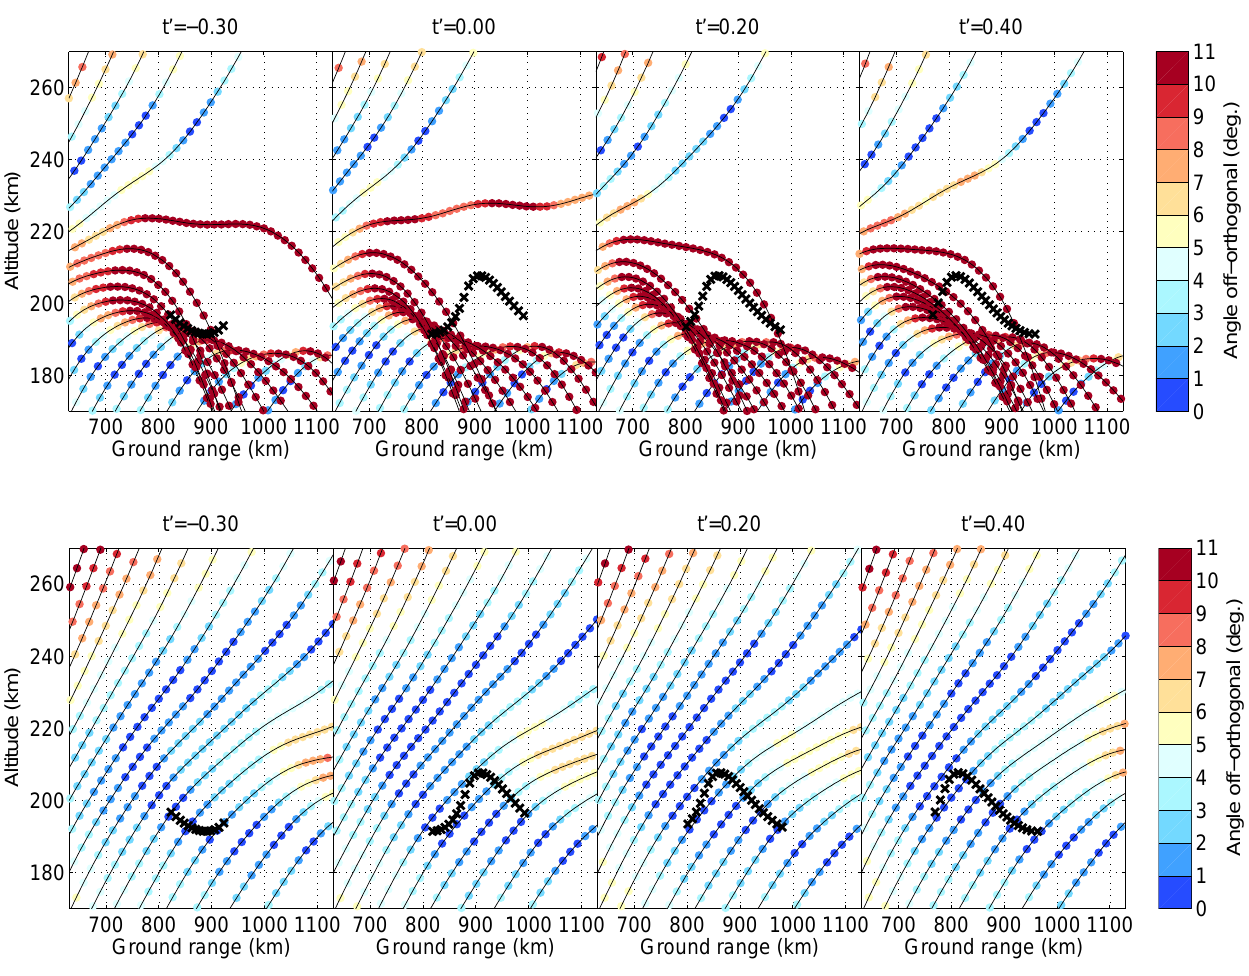
Fig. 6. Top panel: 13-MHz rays from the CUTLASS radar traced through the model ionosphere for TIDs A and B for the four times given at the top of each plot. The shaded circles on each ray indicate the angle from orthogonality. The black crosses indicate where up-going rays from the pump transmitter intersect the upper-hybrid resonance height. Bottom panel: as top panel, but for 18-MHz radar